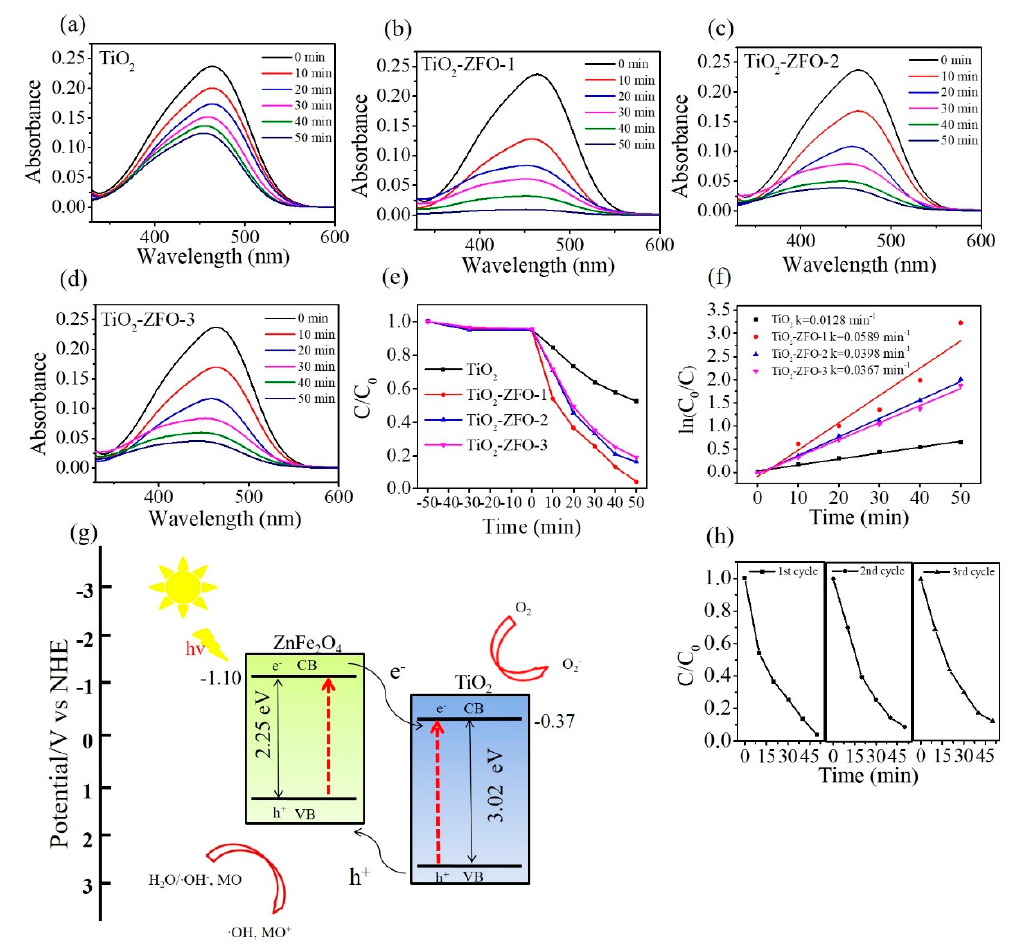
Figure 9. Intensity change of absorbance spectra of MO solution vs. degradation duration containing various nanorods under irradiation: ( a ) pure TiO 2 nanorods; ( b ) TiO 2 –ZFO-1; ( c ) TiO 2 –ZFO-2; ( d ) TiO 2 –ZFO-3. ( e ) Plot of C/C o vs. irradiation time for MO solution containing various nanorods in dark and illumination conditions. ( f ) Plot of ln(C o /C) vs. time. ( g ) Photodegradation mechanism of the TiO 2 –ZFO toward MO dyes. ( h ) Cycling tests.